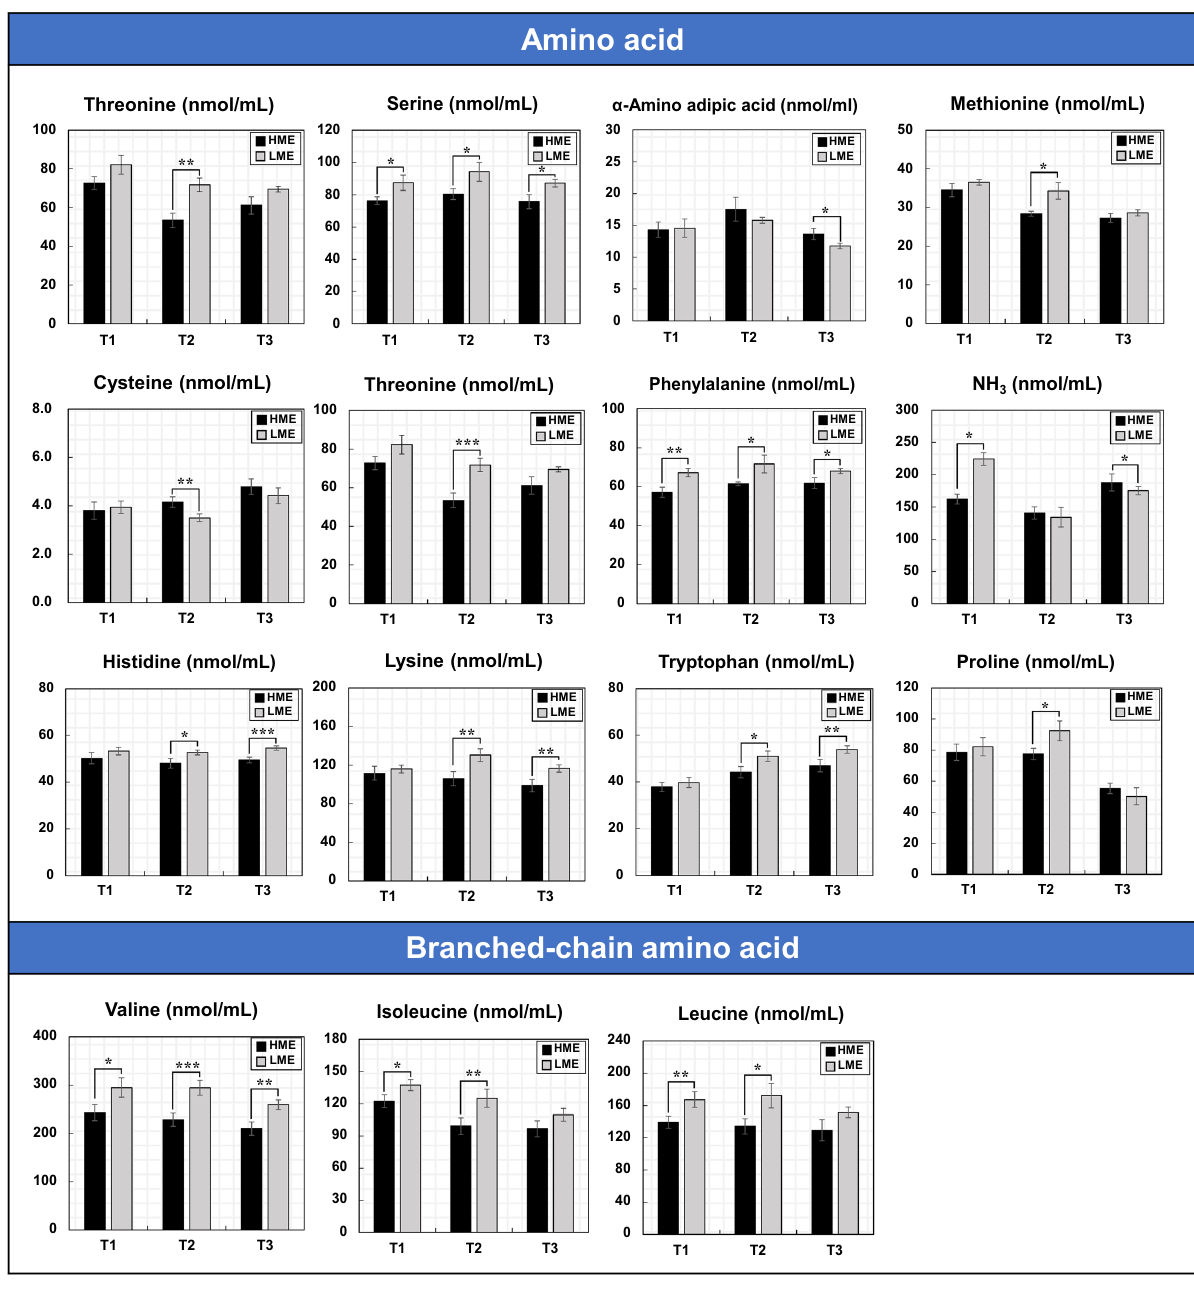
Figure 2. Comparisons of blood amino acid levels in HME vs LME cattle during the fattening period. T1: early fattening phases (13 months of age), T2: middle fattening phases (20 months of age), T3: late fattening phases (28 months of age). HME: group of high methane emission cattle (n = 6), LME: group of low methane emission cattle (n = 6). Data are presented as mean ± SEM. * p < 0.1, ** p < 0.05, and *** p <